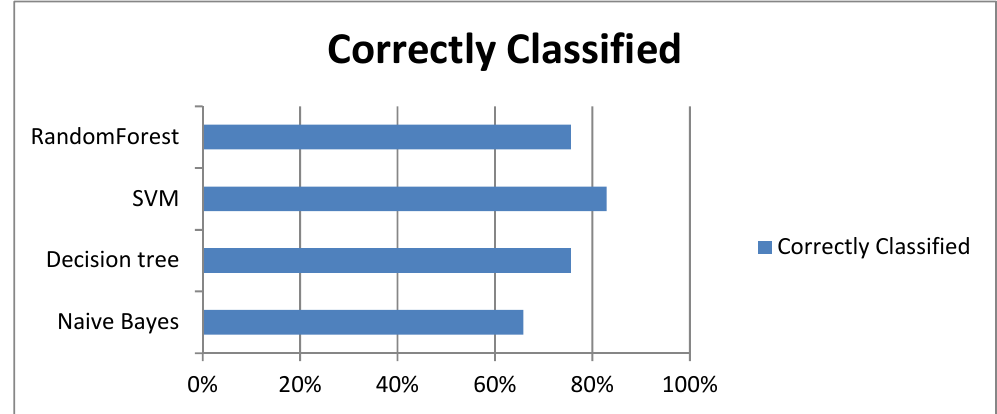
Figure 9. Comparison of the correctively classified index between algorithms.